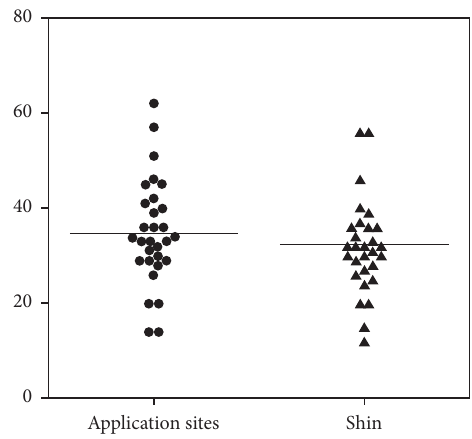
Figure 3: The MDS-UPDRS part III score was significantly lower in the post-RTP group than that in the pre-RTP group ( p < 0 . 05).